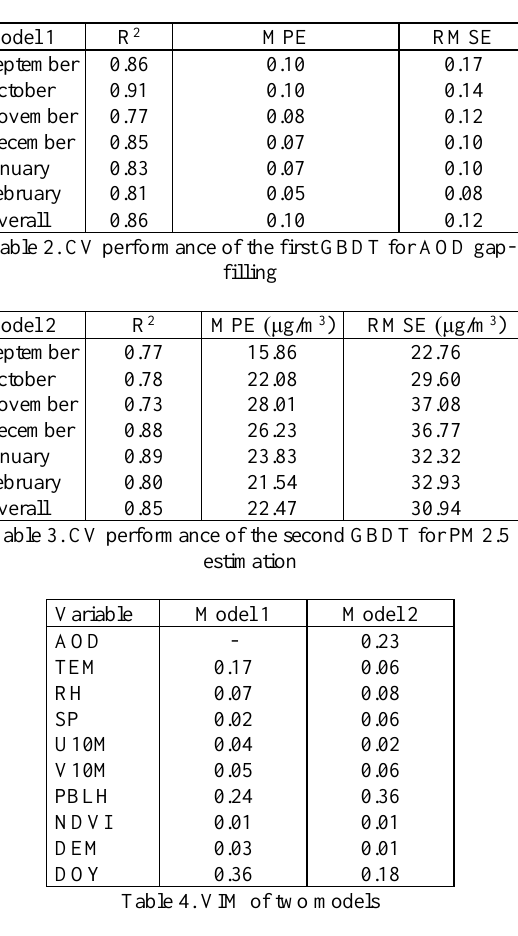
Table 1. Some key parameters selection in two models